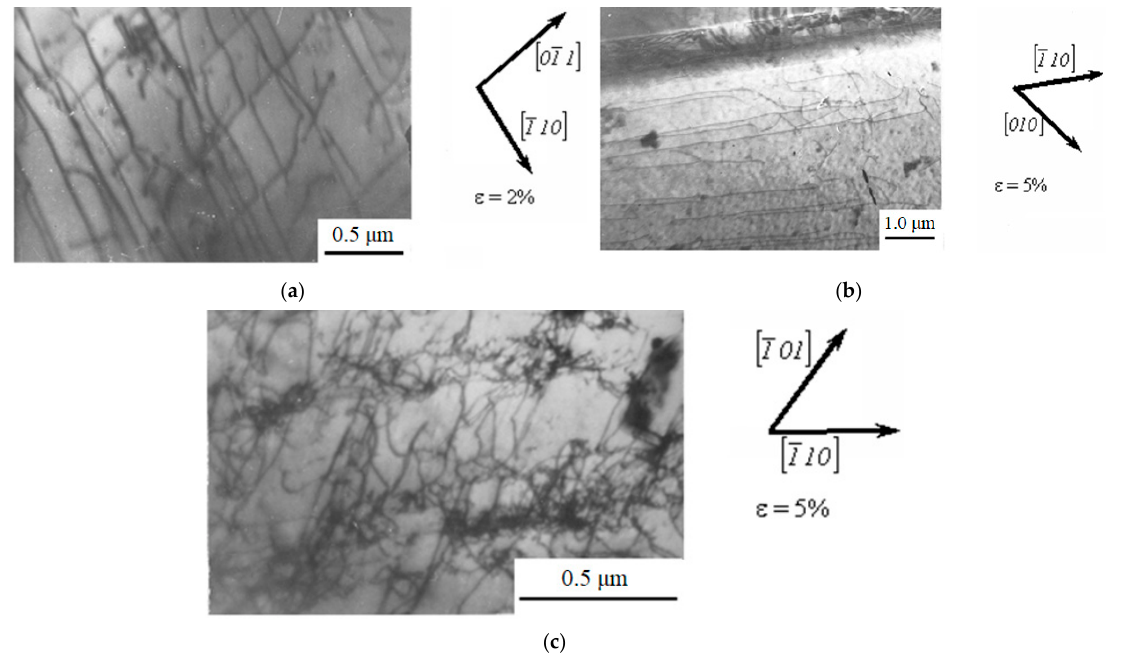
Figure 3. STEM image with EDX analysis of the distribution of elements for a sample of Hadfield steel. TEM results showed that at the initial degrees of deformation (up to ε = 5%), the substructure of the material is represented by randomly distributed dislocations and in- dividual mechanical microtwins (Figure 4).